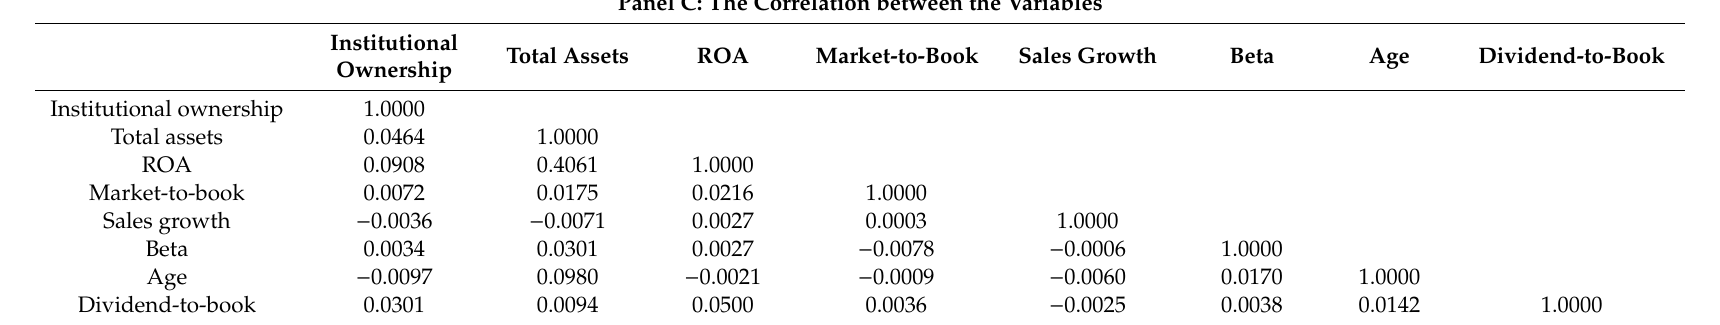
Panel C: The Correlation between the